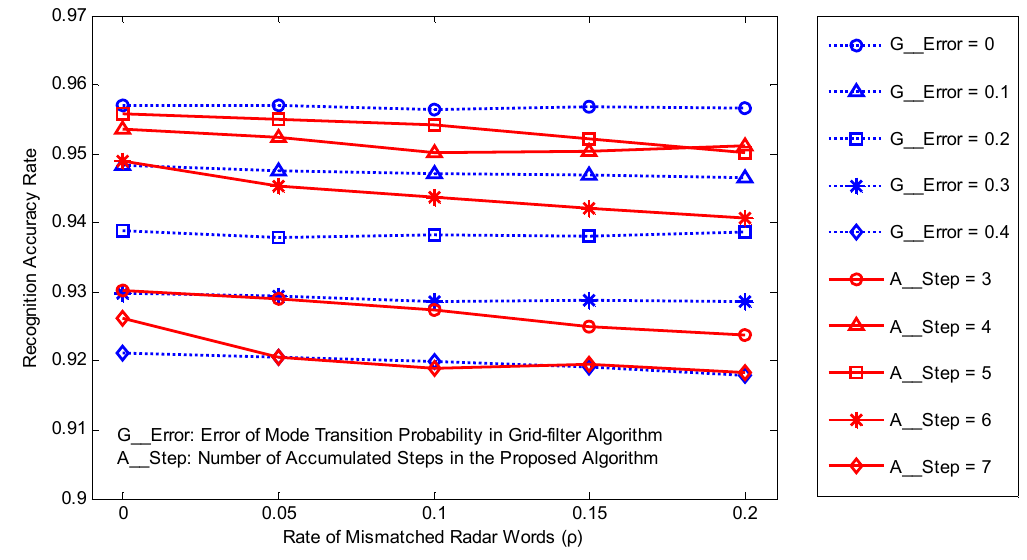
Figure 5. Recognition rate for the two mode recognition algorithms versus the impact factors.